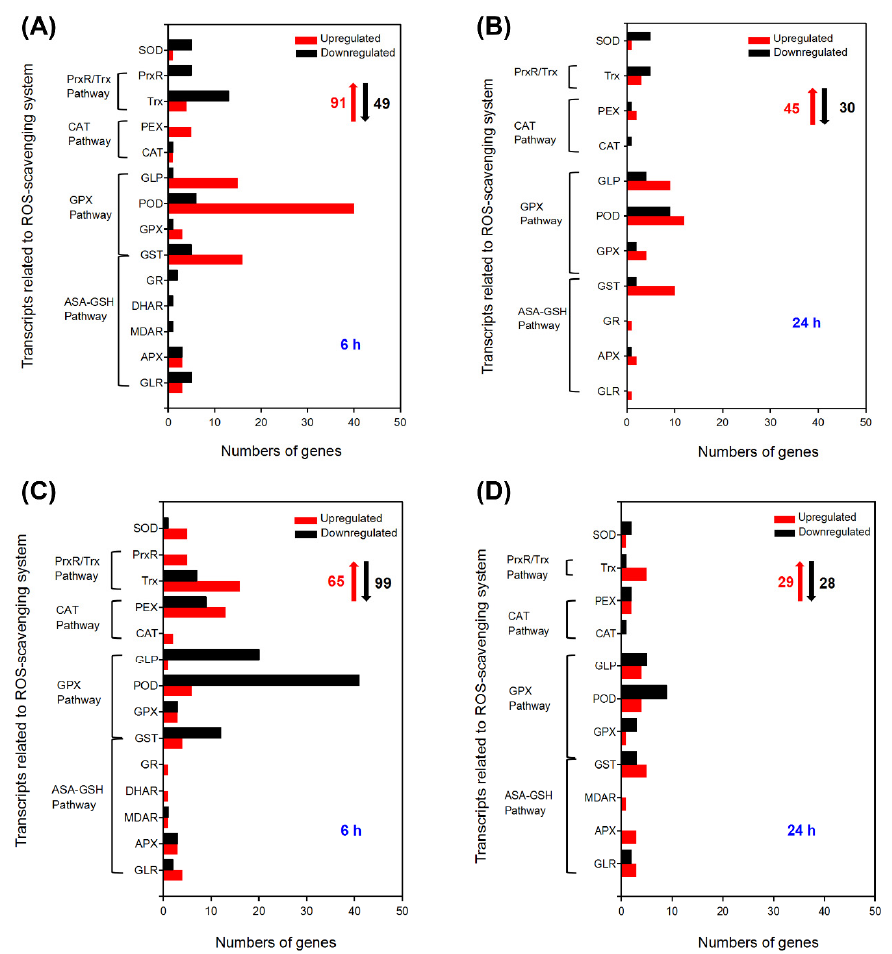
Figure 4. Number of DEGs related to the ROS scavenging system under 100 mM NaCl treatment for 6 and 24 h in leaves ( A , B , respectively) and in roots ( C , D , respectively) of A. canescens . SOD: superoxide dismutase, PrxR: peroxiredoxin, Trx: thioredoxin, PEX: peroxisome biogenesis, CAT: catalase, GLP: germin-like protein, GLR: glutaredoxin, POD: peroxidase, GPX: glutathione peroxidase, GST: glutathione s-transferase, GR: glutathione reductase, DHAR: dehydroascorbate reductase, MDAR: monodehydroascorbate reductase, APX: ascorbate peroxidase. The red upward arrows and black downward arrows show the total number of upregulated DEGs and downregulated DEGs,